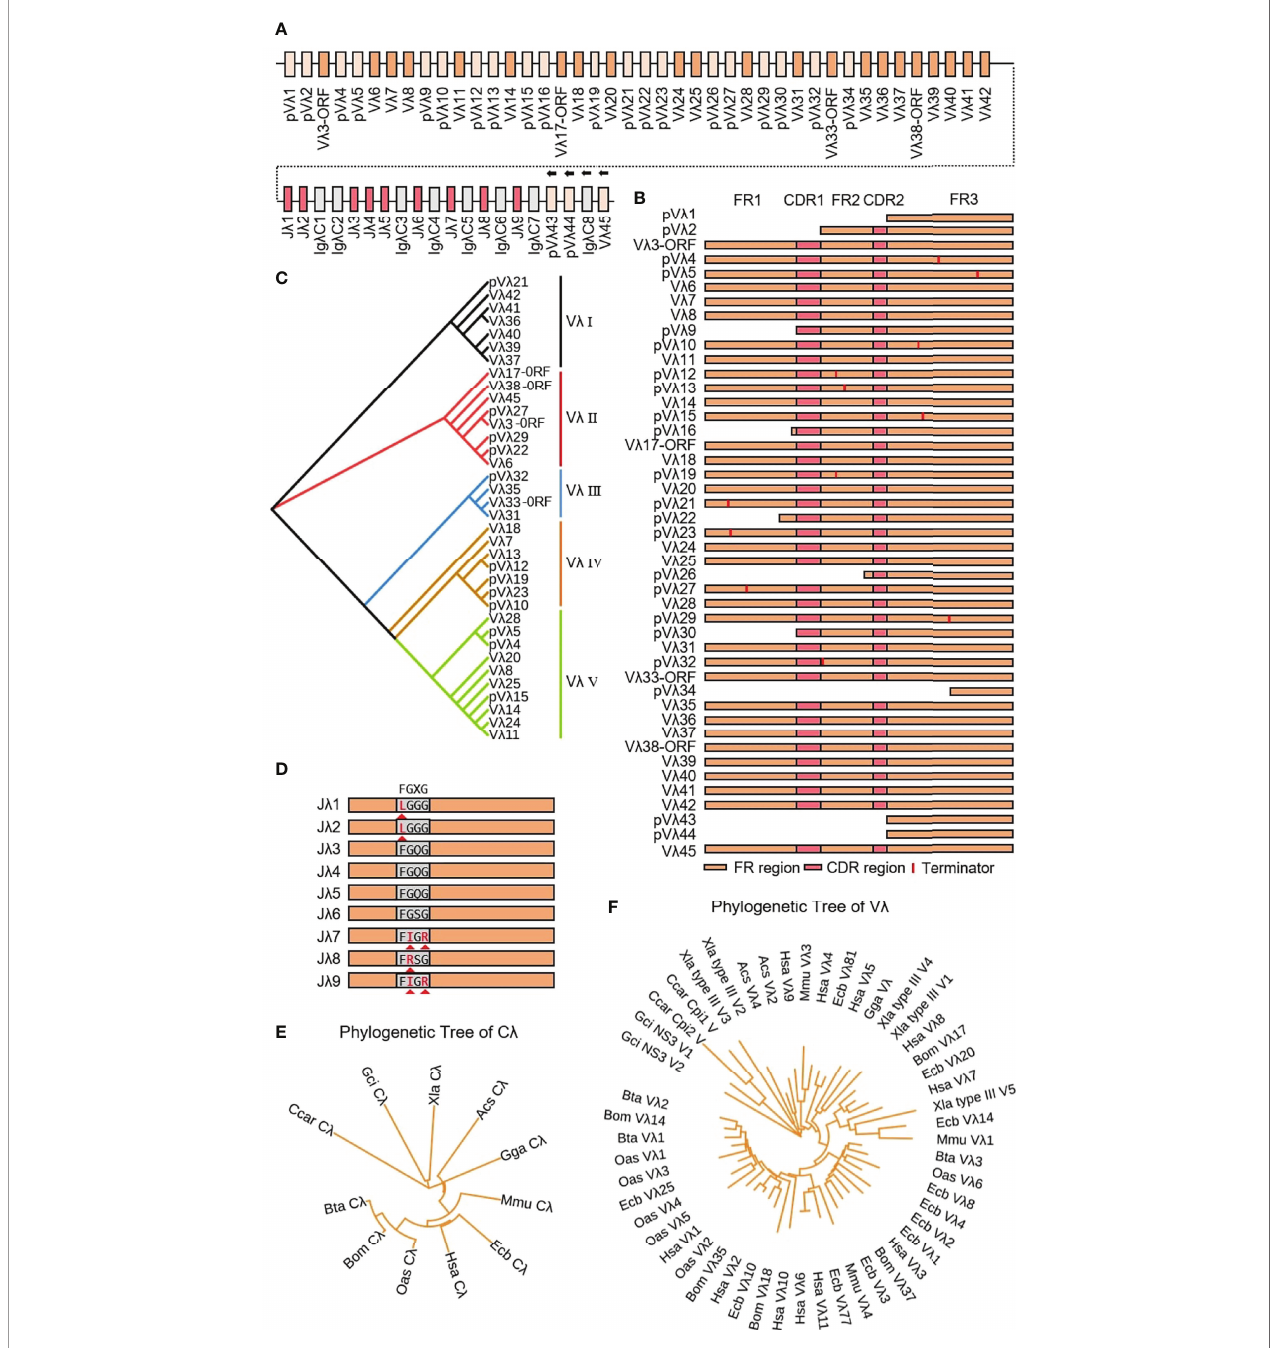
FIGURE 10 | Schematic structure of the genomic organization of Yak IgL( l ) and its relatedness with representative vertebrate species. (A) Schematic structure of the genomic organization of Yak IgL( l ); (B) The structural variation of Yak V l ; (C) The phylogenetic tree of yak V l ; (D) The structural variation of Yak J l ; (E) The phylogenetic tree of C l in yak and representative vertebrate species; (F) The phylogenetic tree of different V l gene family between yak and representative vertebrate